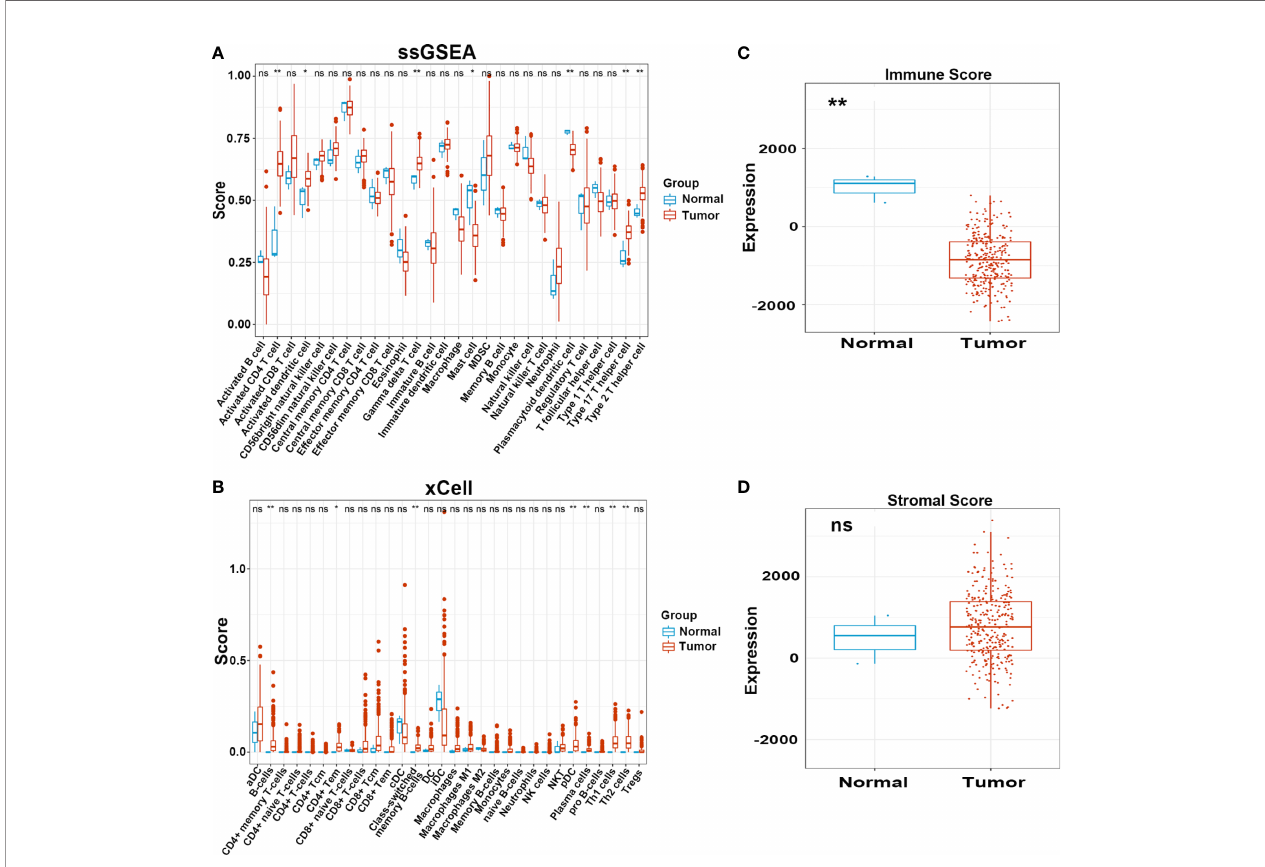
FIGURE 2 | In fi ltration pattern of immune cells in adjacent normal and tumor tissues. (A, B) Level of immune cells in normal and tumor tissues estimated by ssGSEA and xCell. (C, D) Immune and Stromal score in normal and tumor tissues estimated by ESTIMATE. ns, not signi fi cant; * p ≤ 0.05, ** p ≤